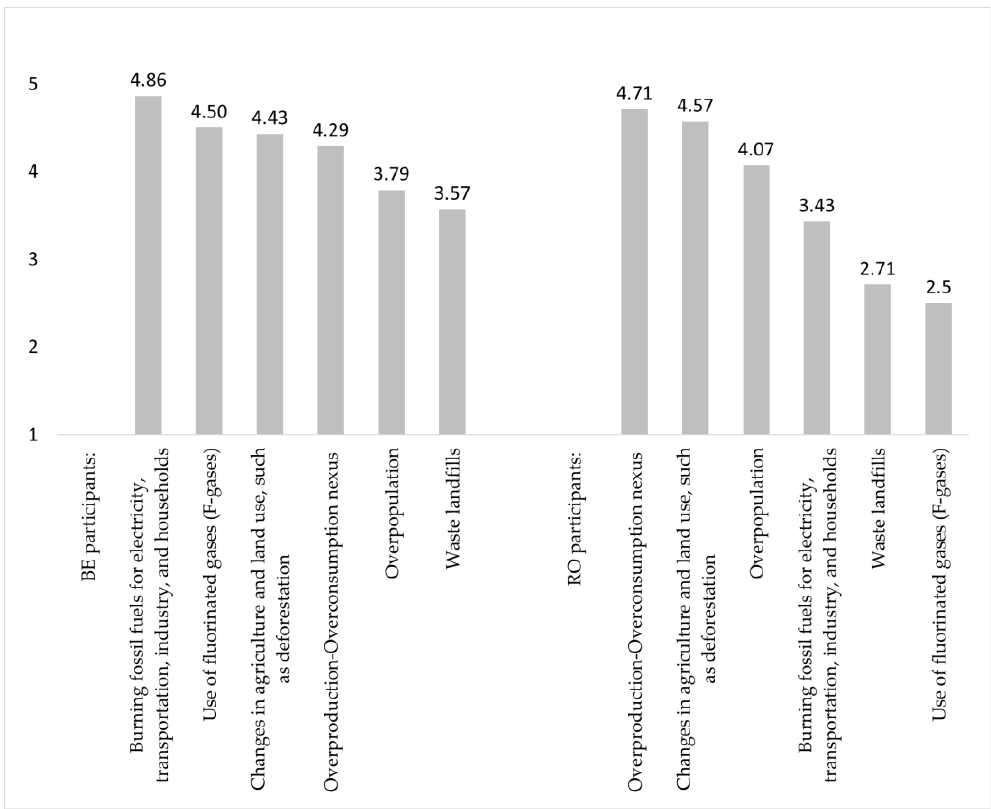
Figure 2. “The King” of CC villains (Belgian and Romanian participants).